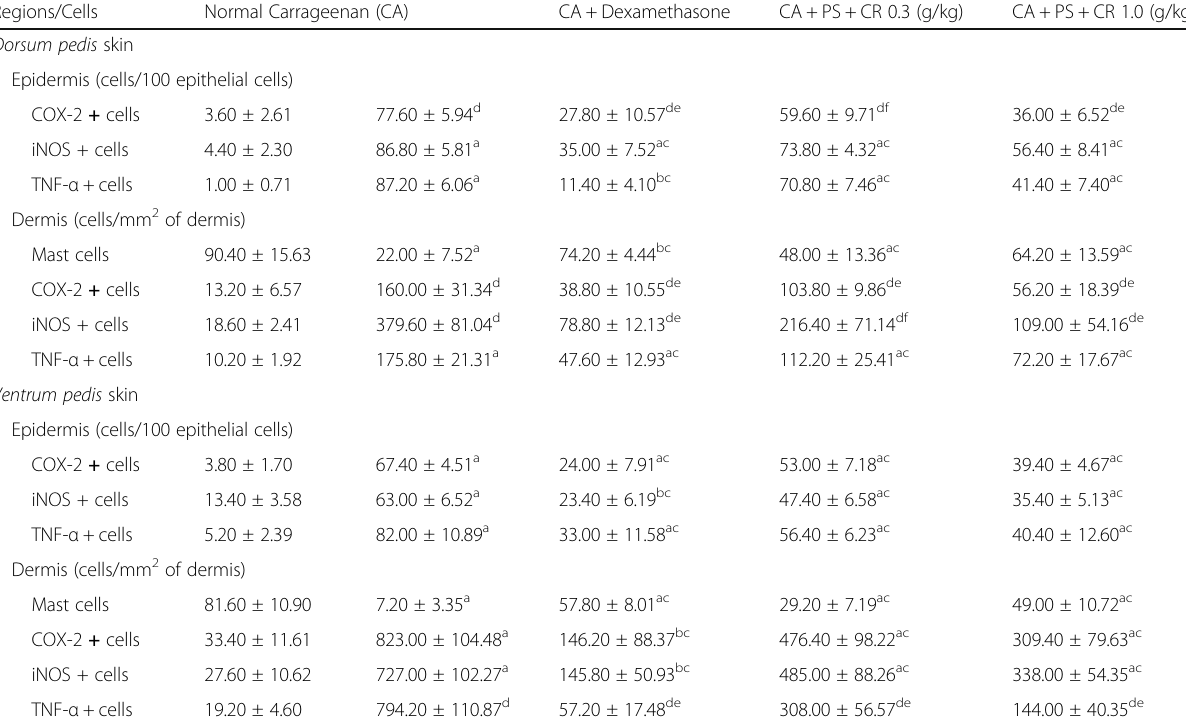
Table 2 Changes on the mast cells, COX-2-, iNOS- and TNF- α -immunoreactive cells in the hind paw skins